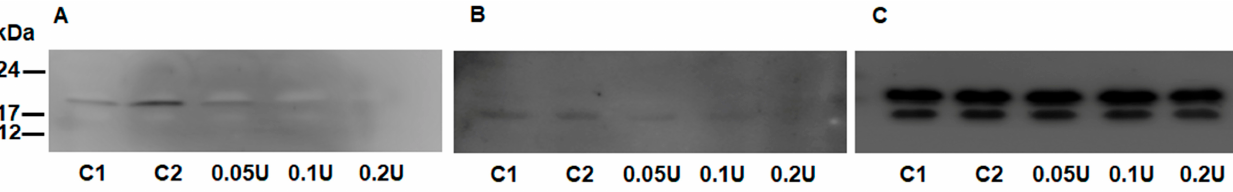
Figure 2. Asialylation of GMP with neuraminidase. The products of GMP-neuraminidase reaction were separated by SDS-PAGE and detected by western blot using: ( A ) SNA lectin, ( B ) MALII lectin, ( C ) or a polyclonal anti-GMP antibody. The amount of neuraminidase used in each reaction is indicated below the lines. C1, intact GMP dissolved in water; C2, intact GMP dissolved in the reaction